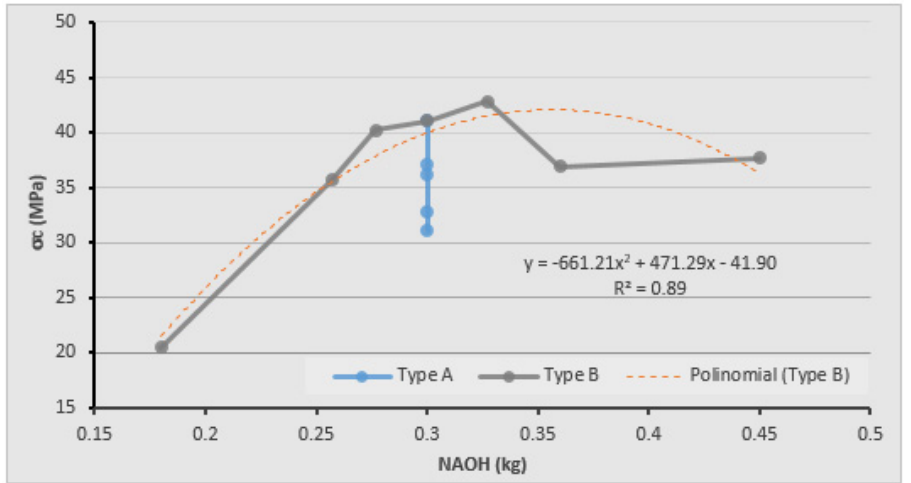
Figure 9. Influence of sodium hydroxide (NaOH) on the compressive strength.